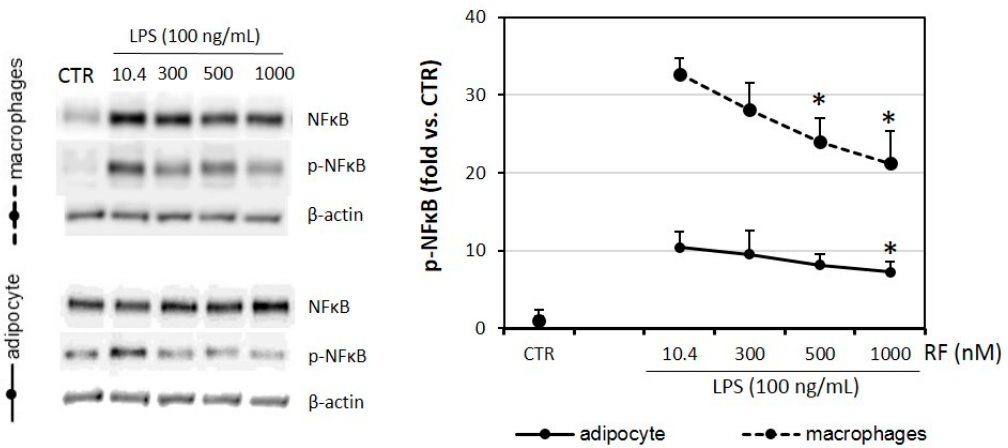
Figure 6. Effects of various riboflavin concentrations (10.4; 300; 500; 1000 nM) on LPS-induced phosphorylation of nuclear factor κ B (p-NF κ B) in co-cultured RAW 264.7 macrophages and 3T3 L1 adipocytes. Fully differentiated adipocytes and macrophages were cultured in 12-well dishes with inserts (0.4 µ m pore size) upon LPS stimulation (100 ng/mL). CTR – control group without